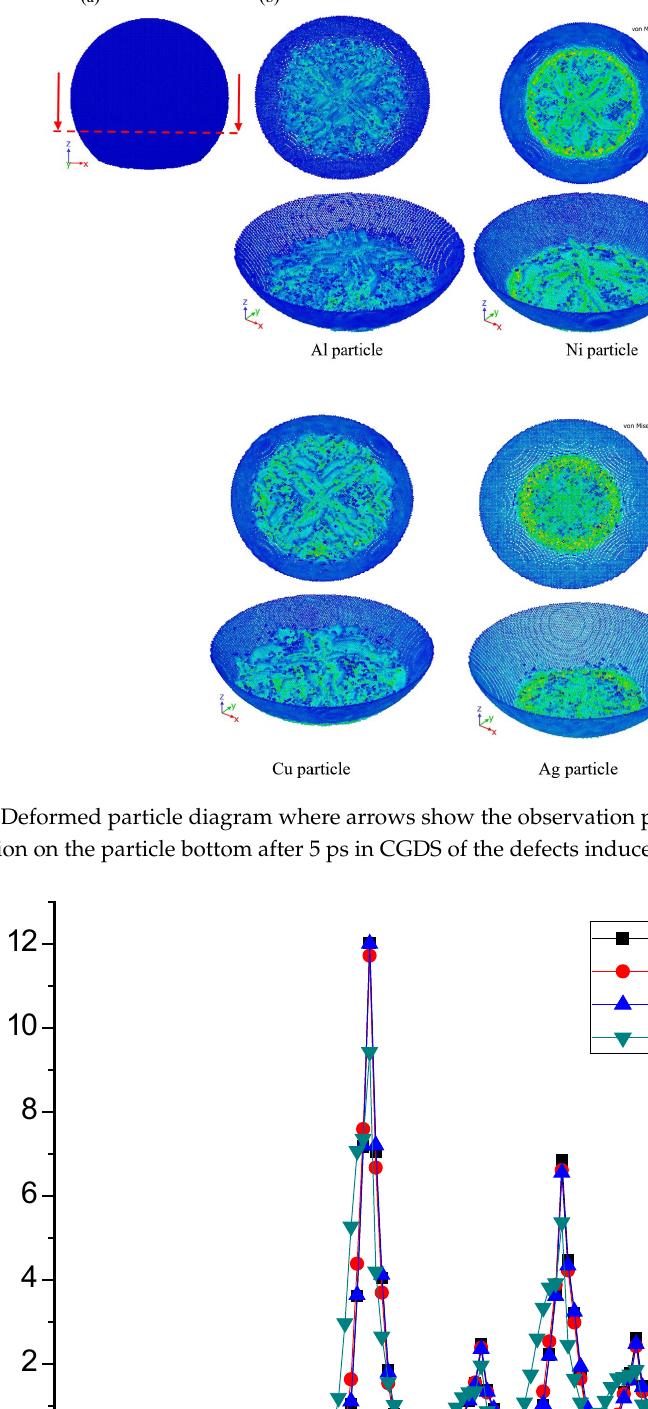
Figure 5. The temporal temperature evolution at the periphery of the particle/substrate interfacial region at 1000 m/s of single-particle impact.